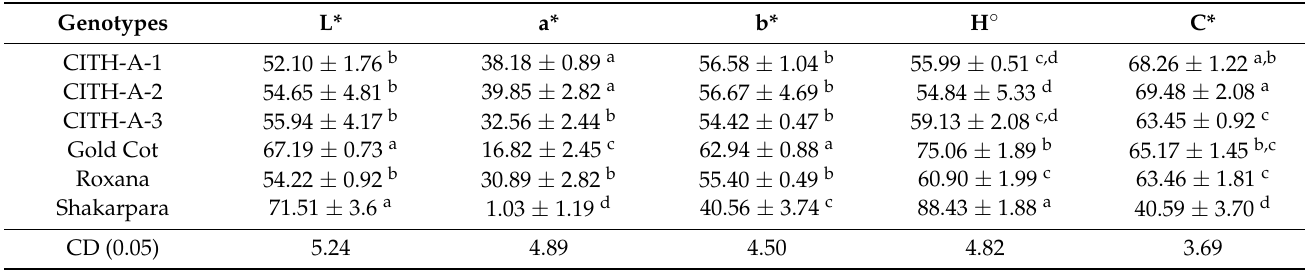
Table 2. Variation in skin colour of apricot genotypes (reflectance measurements L*, a*, b*, hue angle, and chroma).